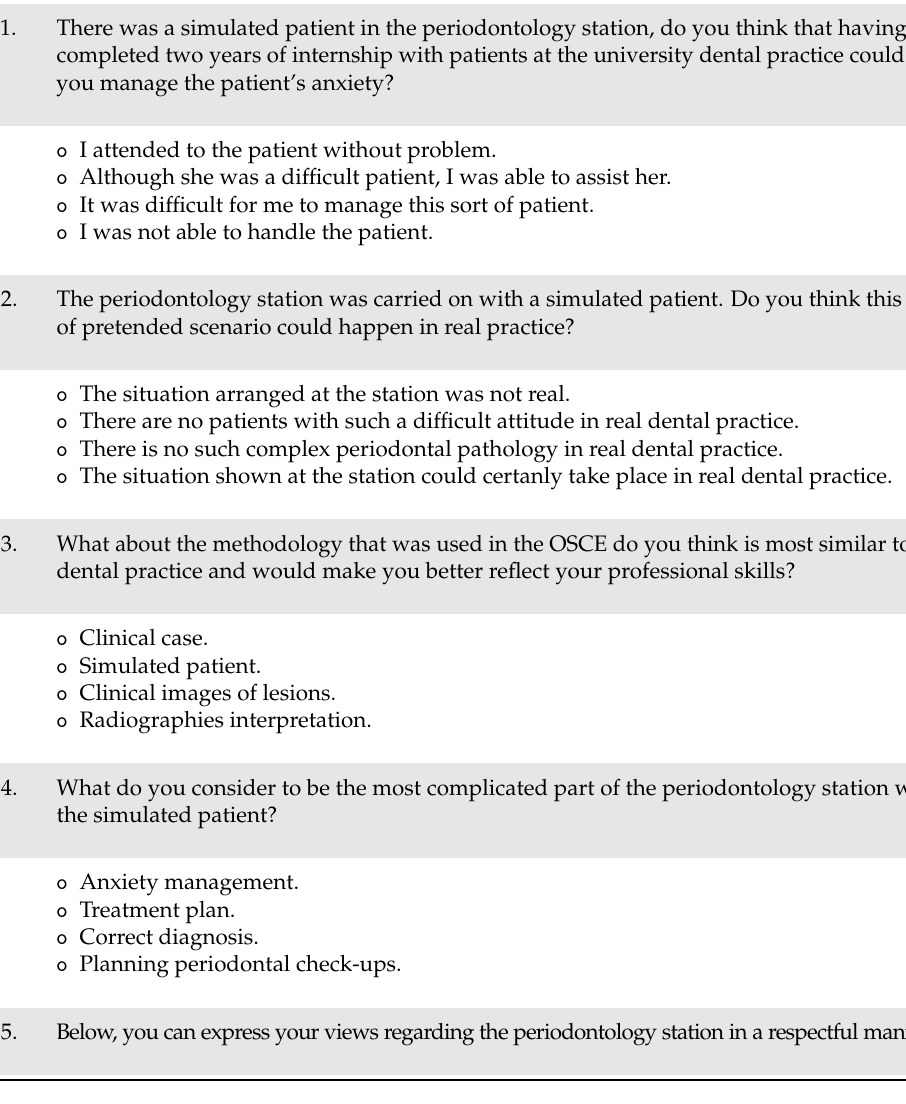
Table 2. Survey and multiple choice